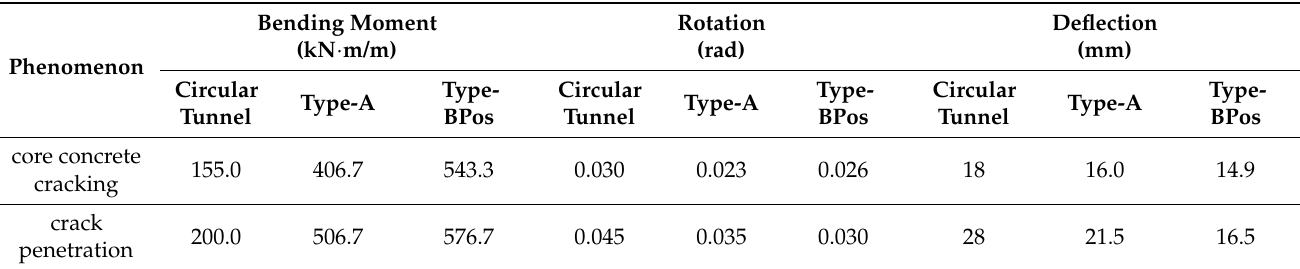
Table 4. Comparison between the joints with DIJPs and joints in a conventional circular tunnel in positive cases. Bending Moment (kN · m/m) Phenomenon Circular Type-A Tunnel core concrete cracking crack penetration